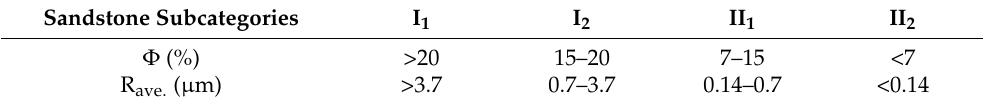
Table 9. The porosities and average pore throat radii of the four subcategories of